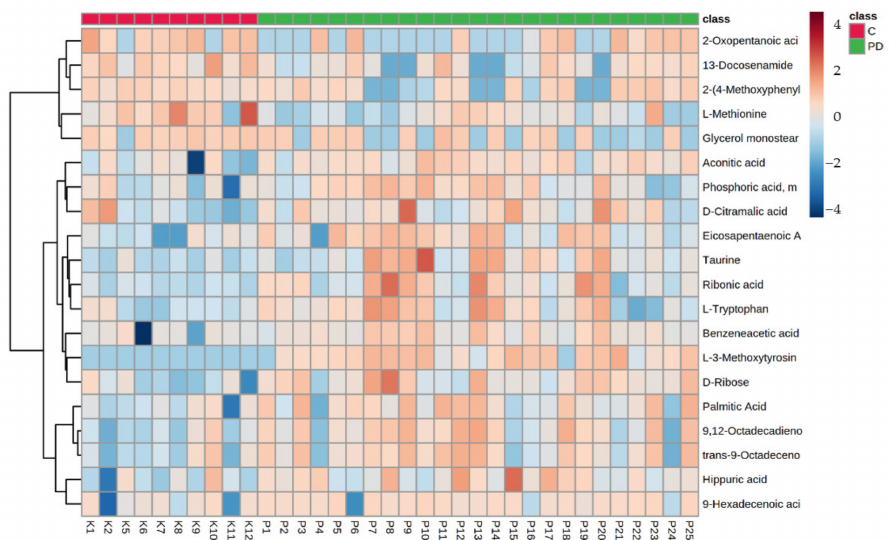
Figure 2. Differential metabolites and perturbed metabolic pathways in PD compared with controls. Heatmap based on Euclidean matrix distance and Ward’s clustering